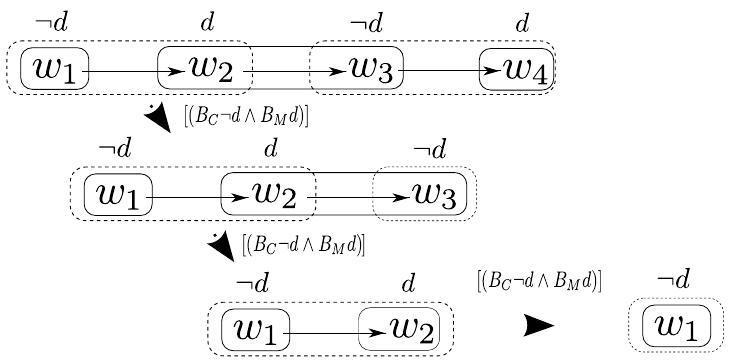
Figure 2. Cobb and Mal’s discussion on the window